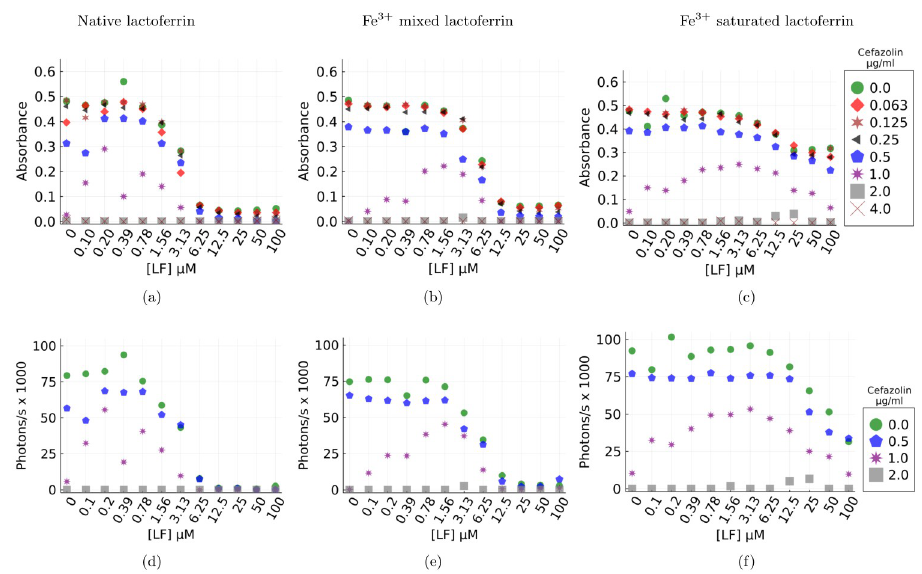
Fig 3. Absorbance and bioluminescence estimates of S. aureus 12–18 hours post treatment by Cefazolin +lactoferrin adjuvant. Markers correspond to concentrations of Cefazolin (eight for absorbance and four for bioluminescence). Each point on the graph represents a biological replicate of three estimates for that lactoferrin concentration. Bioluminescence qualitatively replicates the optical density-based estimate of the population for all the four combined treatments. The data highlights the nonlinear dependence of bacterial growth on lactoferrin adjuvance and its iron-saturation. a, d) Native lactoferrin b, e) Mixed lactoferrin c, f) Saturated